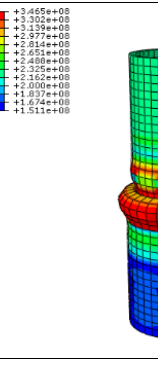
Figure 21. Shear stress diagram of a sleeve.